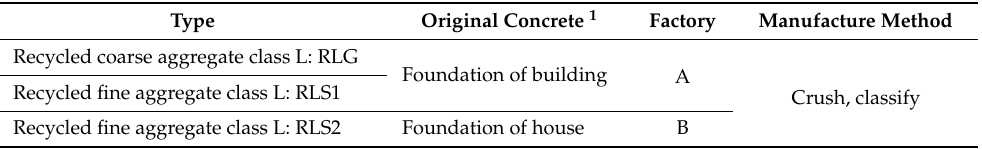
Table 3. Outline of recycled aggregate.